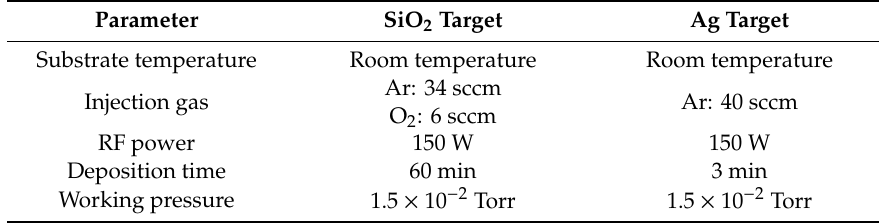
Table 1. Radio frequency (RF) magnetron sputtering condition of SiO 2 and Ag